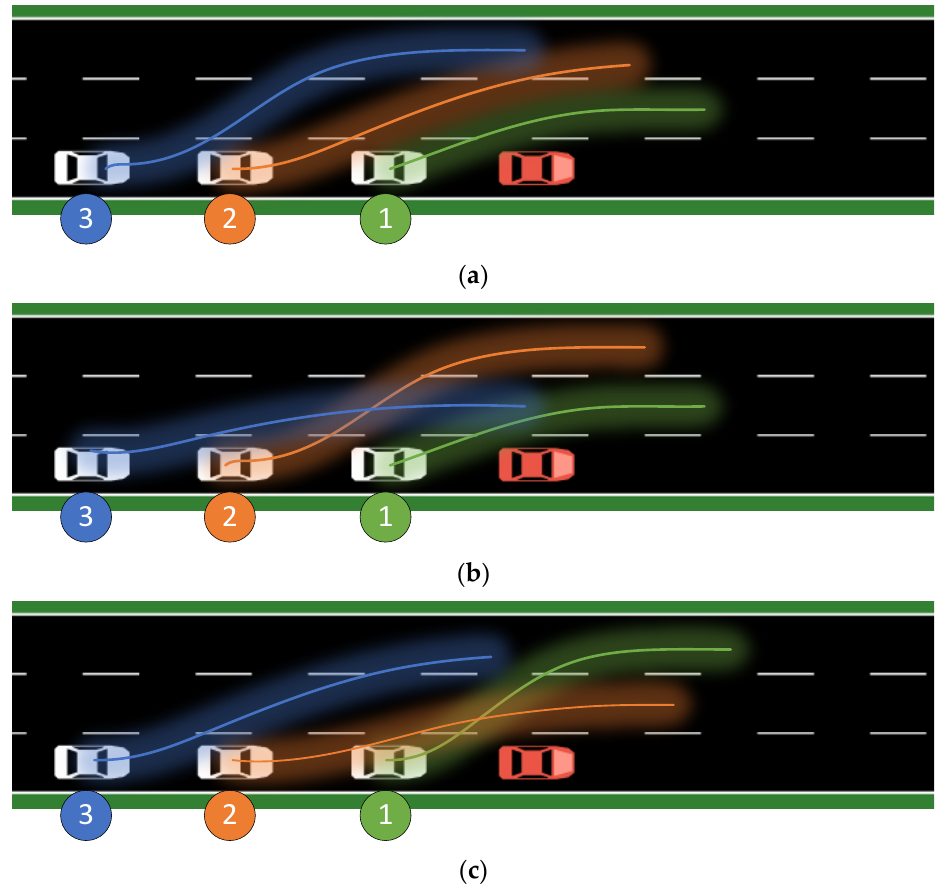
Figure 7. Results of agent training with minimum operational loss priority. The trajectories of ( a ) car 1 changing to lane 2; car 2, 3 to 3; ( b ) car 1, 3 changing to lane 2; car 2 to 3; ( c ) car 1 changing to lane 2; car 2, 3 to 3.